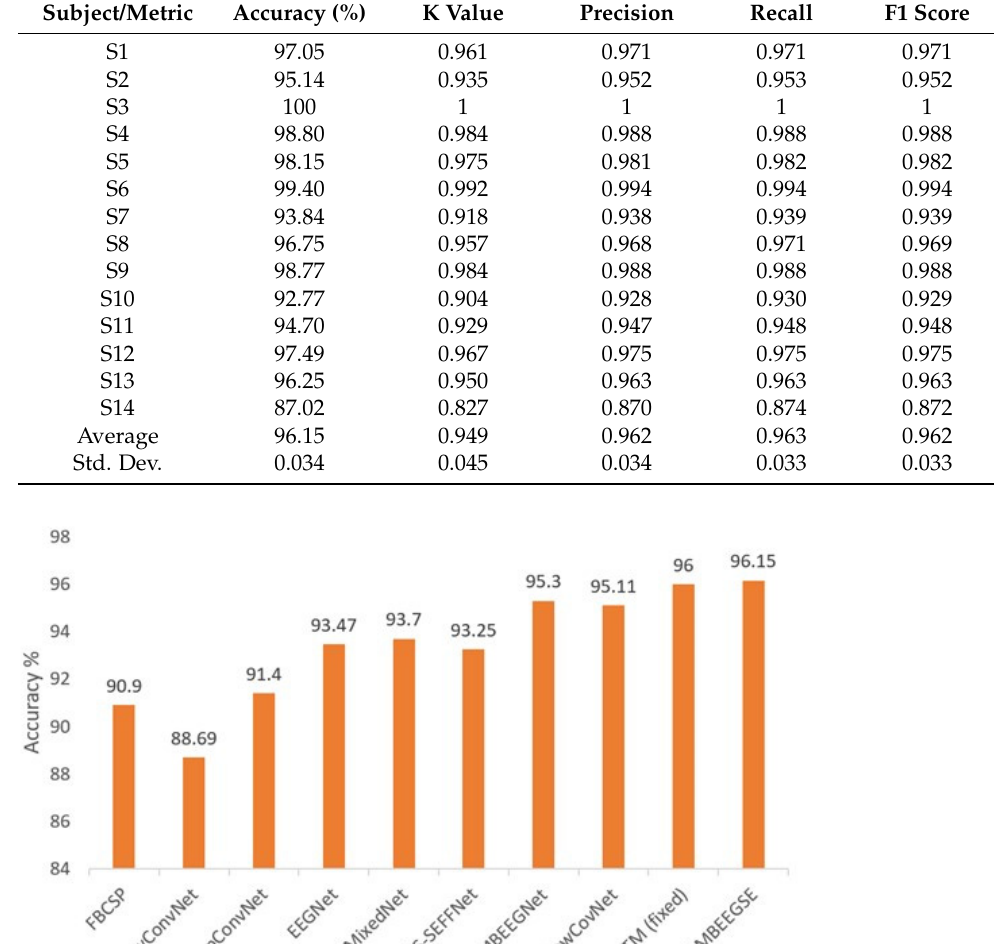
Table 6. Performance metrics on the HGD dataset using the MBEEGSE.